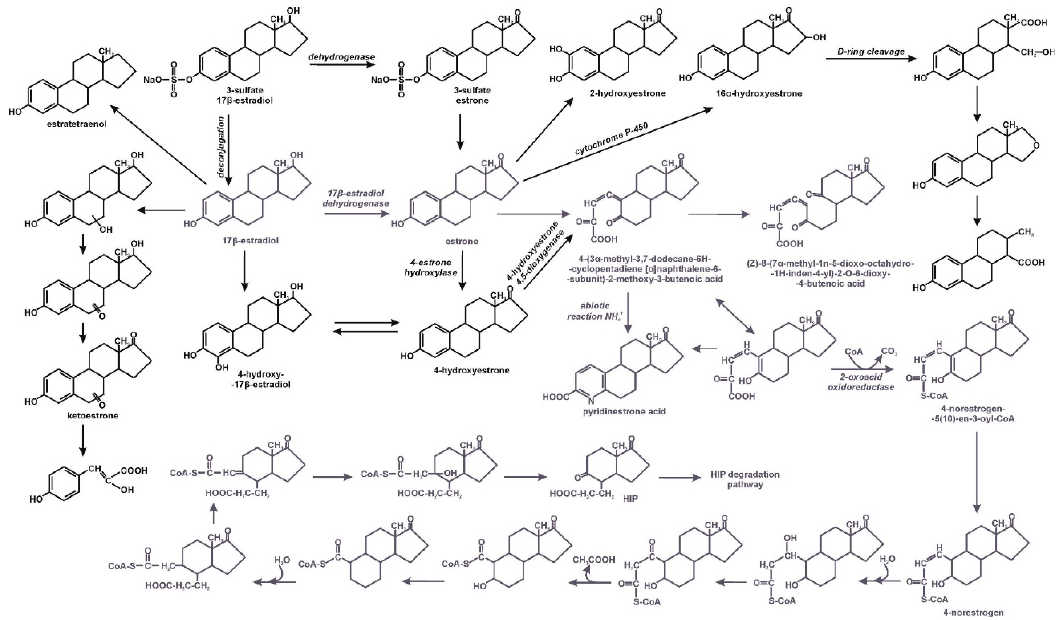
Figure 2. Estrogens biodegradation by bacteria; the 4,5-seco pathway reactions are shown in blue; HIP–9,17-dioxo-1,2,3,4,10,19-hexanorandrostan-5-oic acid [10,12,21,25,50].